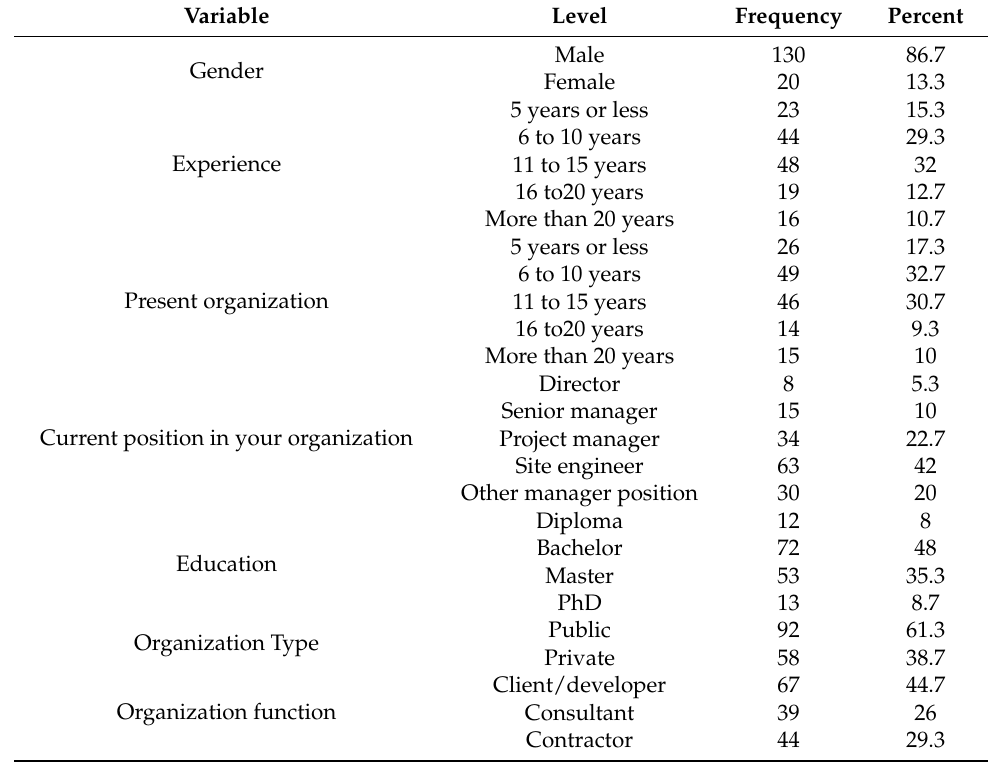
Table 3. The demographic